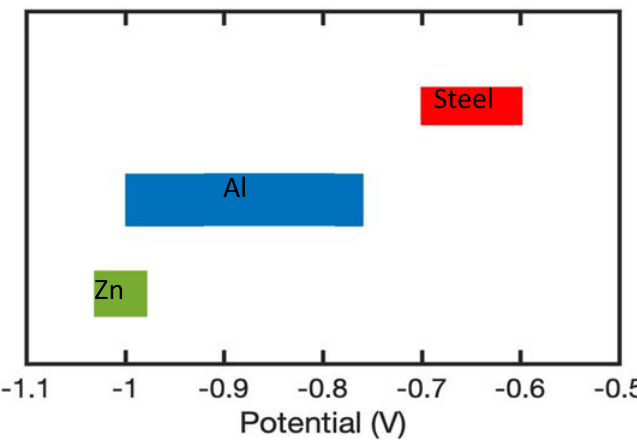
Figure 1. Galvanic series in seawater showing corrosion potential of steel, Al, Zn and their alloys. All values are against saturated calomel electrode (SCE).